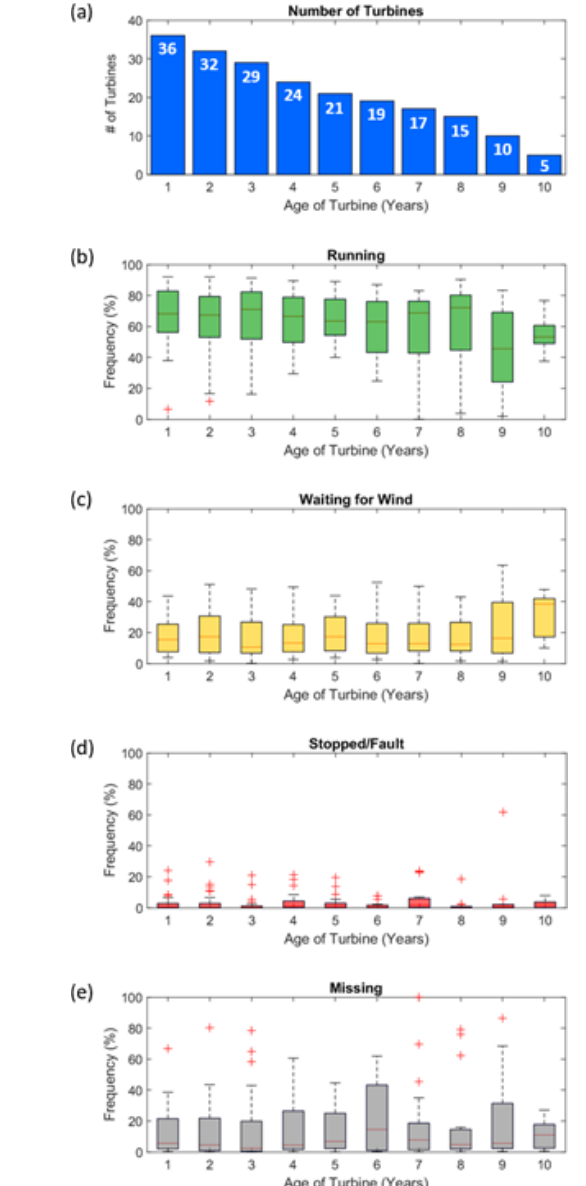
Figure 10. (a) Number of turbines with availability data. Annual frequency of time that 36 small wind turbines are in states of (b) running, (c) waiting for wind, (d) stopped/fault, or (e) missing